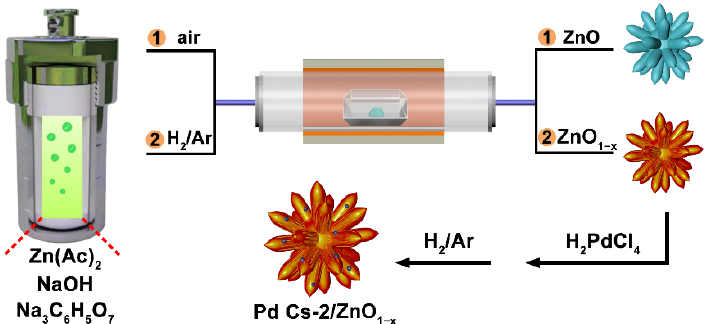
Scheme 1. Illustration of the synthesis of all gas-sensing materials (ZnO, ZnO 1−x , Pd Cs-1/ZnO 1−x , Pd Cs-2/ZnO 1−x , Pd Cs-3/ZnO 1−x